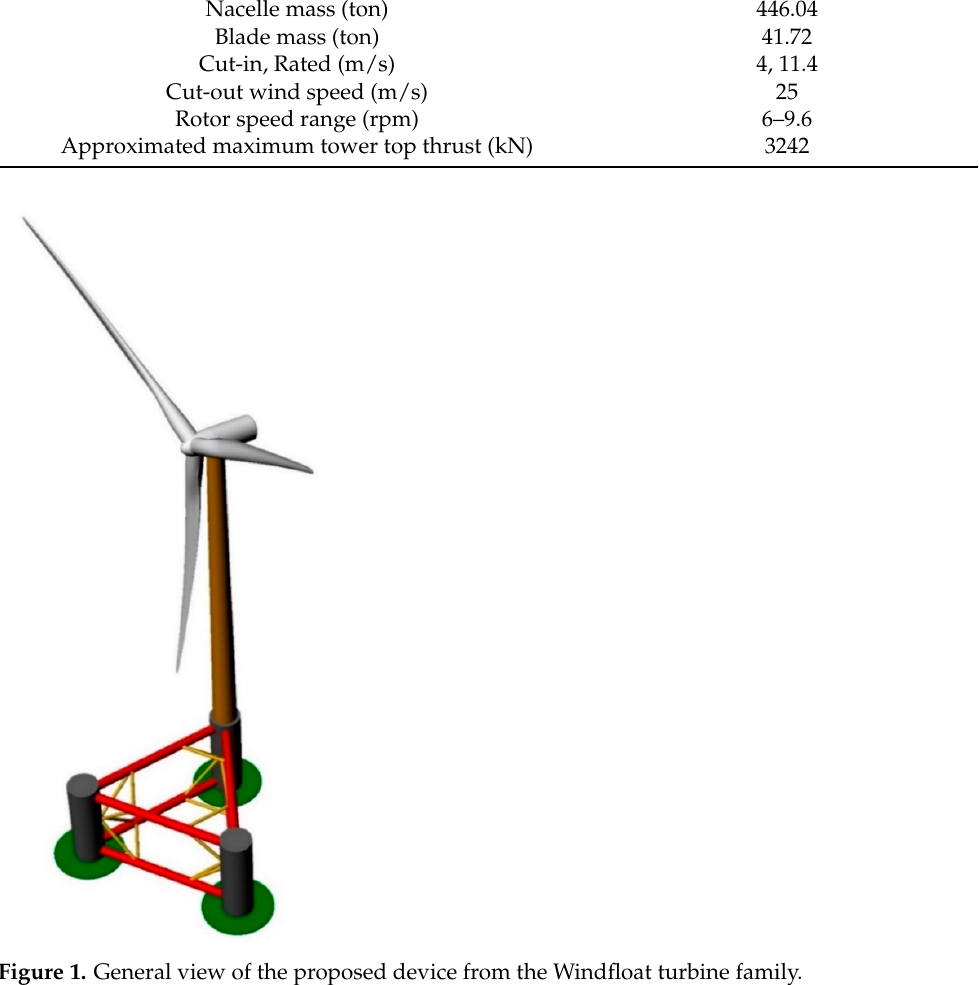
Table 2. Main dimensions of the wind turbine (taken from [25]).